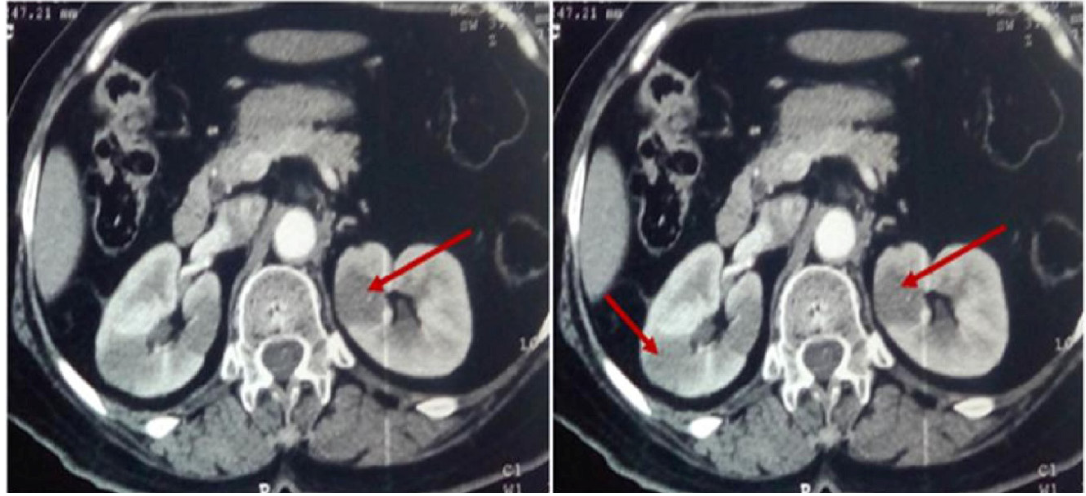
Figure 1: CT scan showing bilateral renal